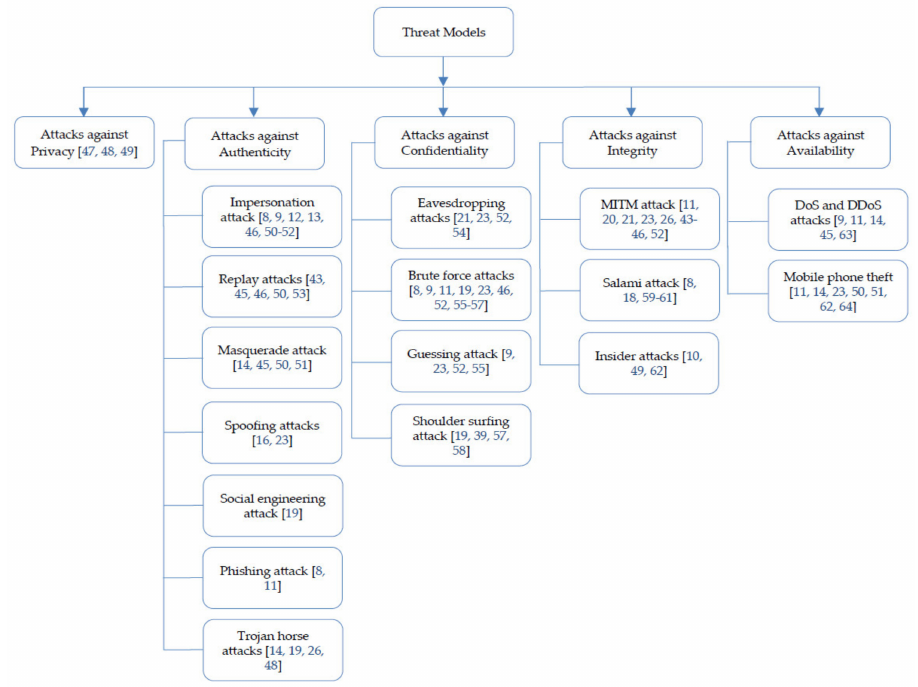
Figure 5. Classification of threat models in mobile money’s two-factor authentication (2FA)